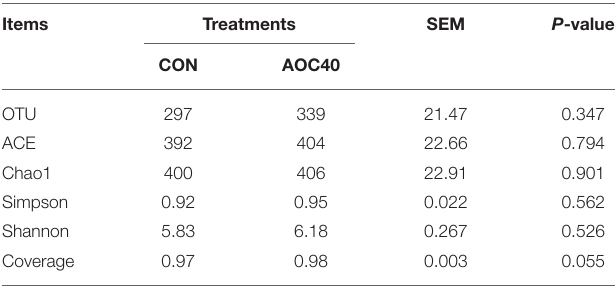
TABLE 5 | Effects of Aspergillus oryza e culture supplementation on α diversity indices of rumen microbial community of Hu sheep.